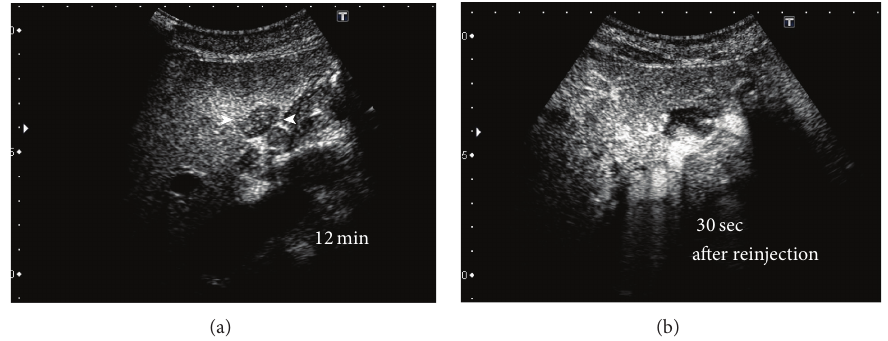
Figure 3: US, employing the “defect reperfusion US imaging” technique with Sonazoid, was performed on another hepatic hemangioma, in the left lobe of the liver, in tumor 1. (a) Preinjection image shows a hypoechoic mass measuring about 2 cm (arrowhead). (b) The lesion shows “peripheral-nodular enhancement” 30s after reinjection of Sonazoid.